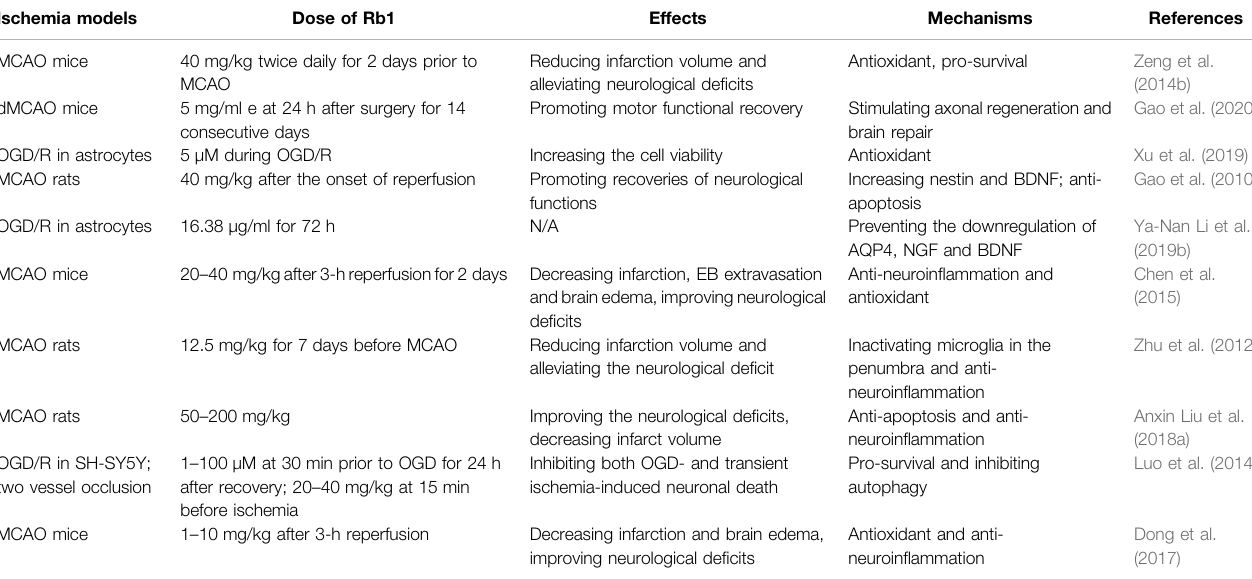
TABLE 3 | The neuroprotection of ginsenoside Rb1 in cerebral